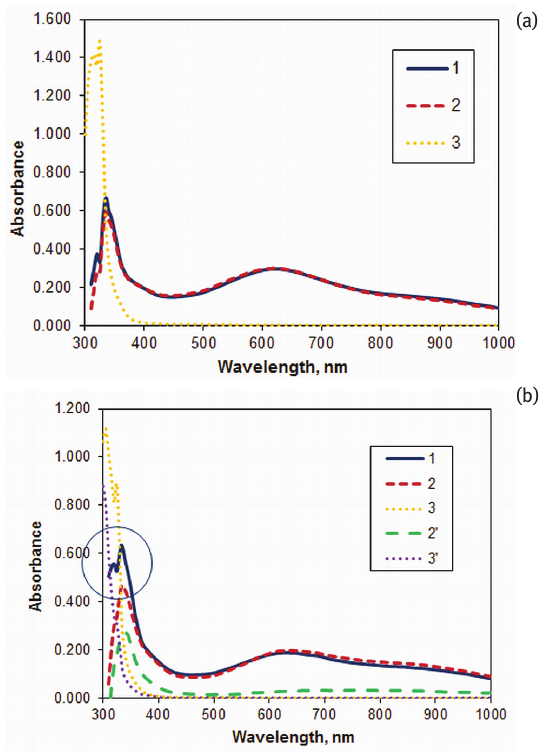
Figure 1: Absorption spectra in chloroform. 1: V IV -DN-TTC against blank; 2 and 2’: V V -DN-TTC against blank; 3 and 3’: blanks (DN-TTC) against chloroform. Conditions: c = 1.0×10 −3 mol dm −3 , pH 5.5. a) c 4.0×10 −4 mol dm −3 (1 – 3) and c